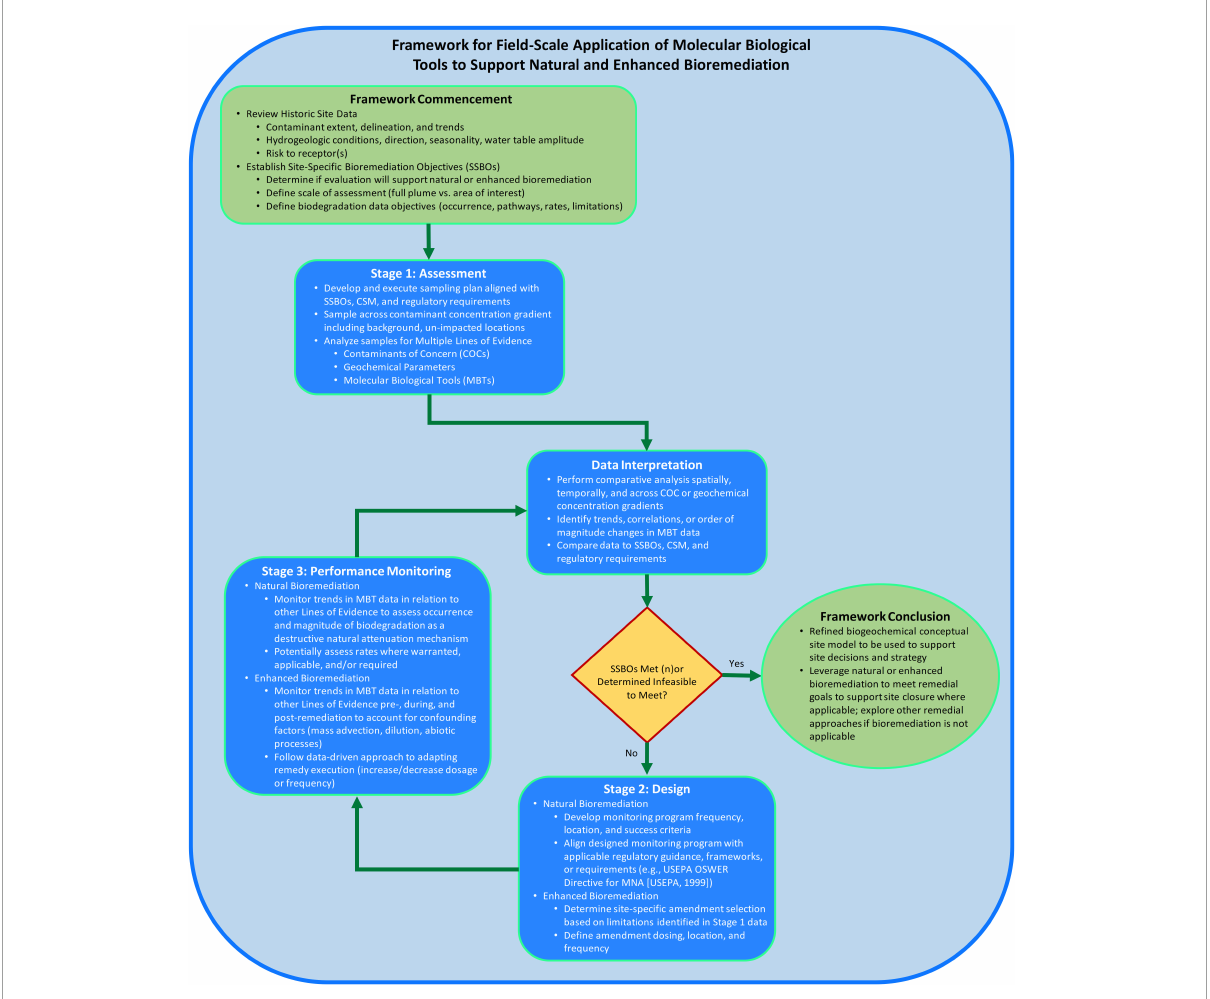
FIGURE2 Framework for field-scale application of molecular biological tools (MBTs) to support bioremediation process flow diagram consisting of logic and considerations for when, where, why, and how to apply MBTs at the field-scale to support site decision-making.